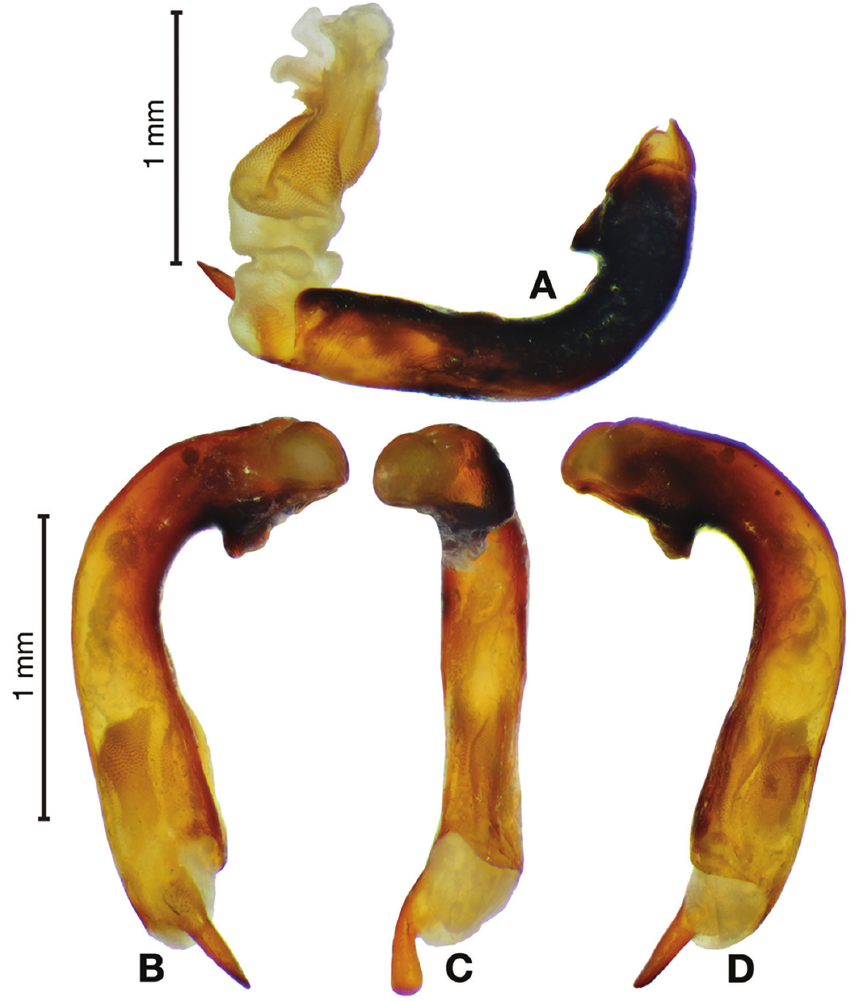
Figure 84. Digital images of male genitalia of Horniulus andrewesi Jedlička. A right lateral aspect, en- dophallus everted B right lateral aspect C ventral aspect D left lateral Female genitalia . Fig. 94B. Width 1.28 – 1.56 mm. Gonocoxite 2 (gc2) nar-